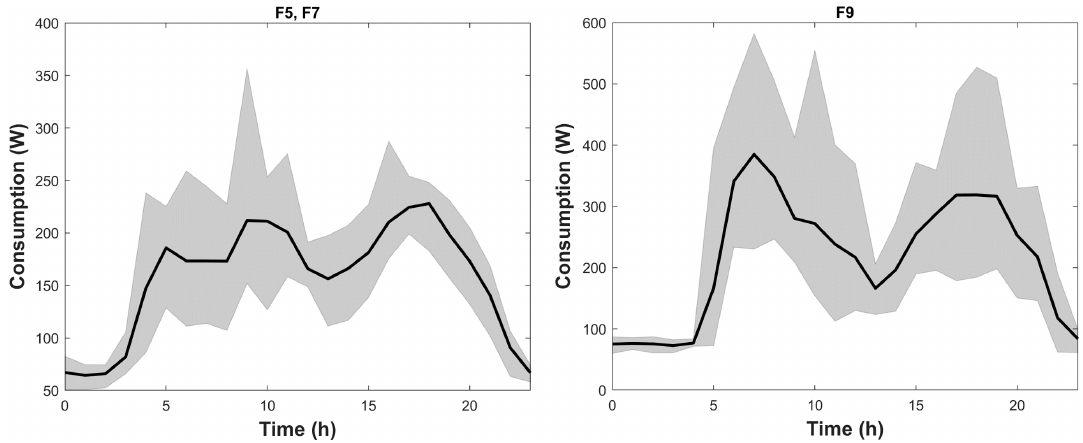
Figure 4. Hourly average annual load profiles of the flats with two old persons (F5, F7), and a flat (F9) with two persons working outside.